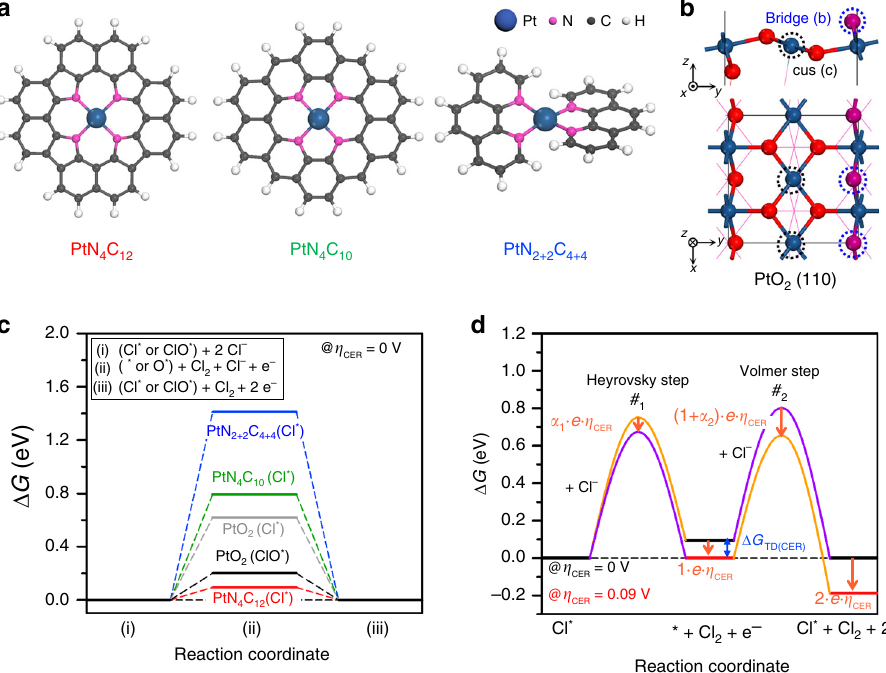
Fig. 4 DFT calculations of plausible model systems of Pt − N 4 sites and PtO 2 in CER and OER conditions. a Model system for possible structural con fi gurations of Pt − N 4 sites including PtN 4 C 12 , PtN 4 C 10 and PtN 2 + 2 C 4 + 4 and b PtO 2 (110) surface. c Free energy diagrams for CER over Pt – N 4 clusters and PtO 2 (110) surface at zero overpotential ( η CER = 0 V). d Full free energy diagram along the reaction coordinate of CER over Pt 1 /CNT catalyst at the respective overpotential for CER ( η CER ) of 0 V (black thick lines) and 0.09 V (red thick lines). α 1 and α 2 represent the transfer coef fi cients at each transition state (TS), which are determined as 0.83 and 0.58 from the experimental Tafel plots, respectively. The TS with higher free energy at the respective η CER is indicated by purple line. Orange arrows represent the decreased amounts of free energies by applied η CER for each state [i.e., fi rst TS (denoted as ‘ # 1 ’ ), intermediate state, second TS (denoted as ‘ # 2 ’ ), and fi nal state, respectively]. The free energy change for reaction intermediate at zero overpotential ( Δ G TD (CER) ) is indicated by blue structure were theoretically elucidated by DFT calculations (Supplementary Note 1). We considered three plausible models representing the atomically dispersed Pt − N 4 sites (i.e., PtN 4 C 12 , PtN 4 C 10 and PtN 2 + 2 C 4 + 4 , Fig. 4a), which were identi fi ed as the active sites for CER in Pt 1 /CNT through the EXAFS and in situ